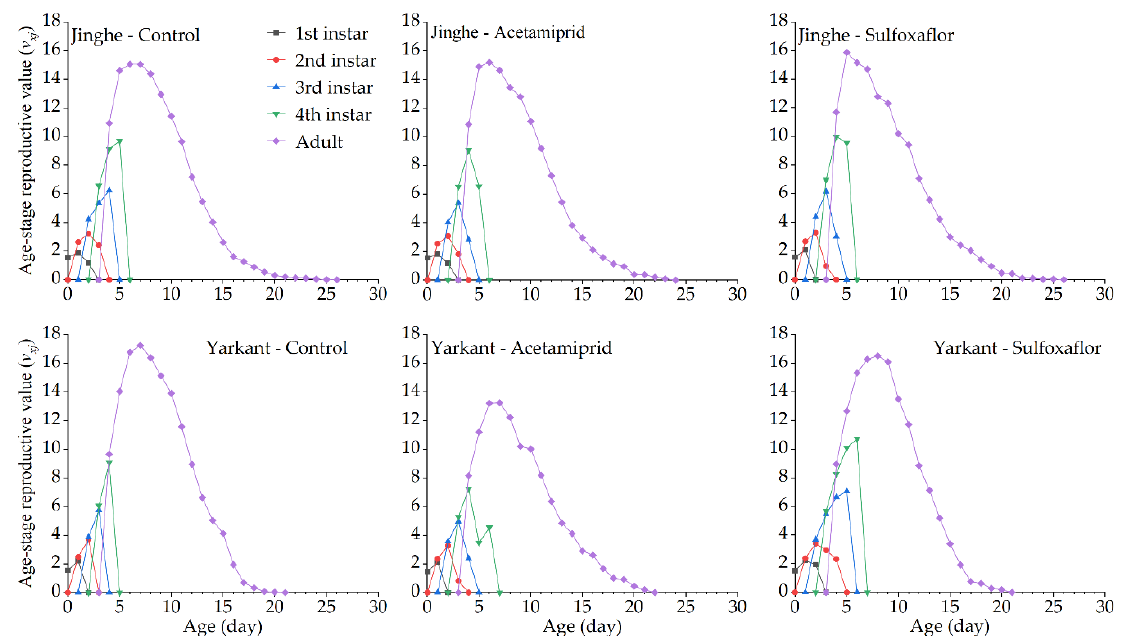
Figure 6. Effects of sublethal concentrations (LC 25 ) of acetamiprid and sulfoxaflor on the age-specific survival rate ( l x ), age-specific fecundity ( m x ), and age-specific maternity ( l x m x ) of A. gossypii of the F 2 generation in Yarkant and Jinghe.